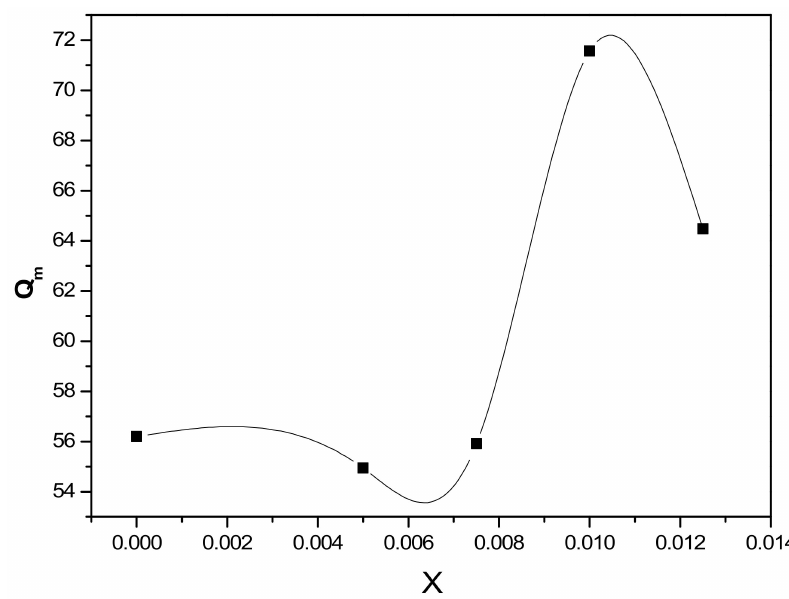
Figure 8. Mechanical quality factor (Q m ) with Sm